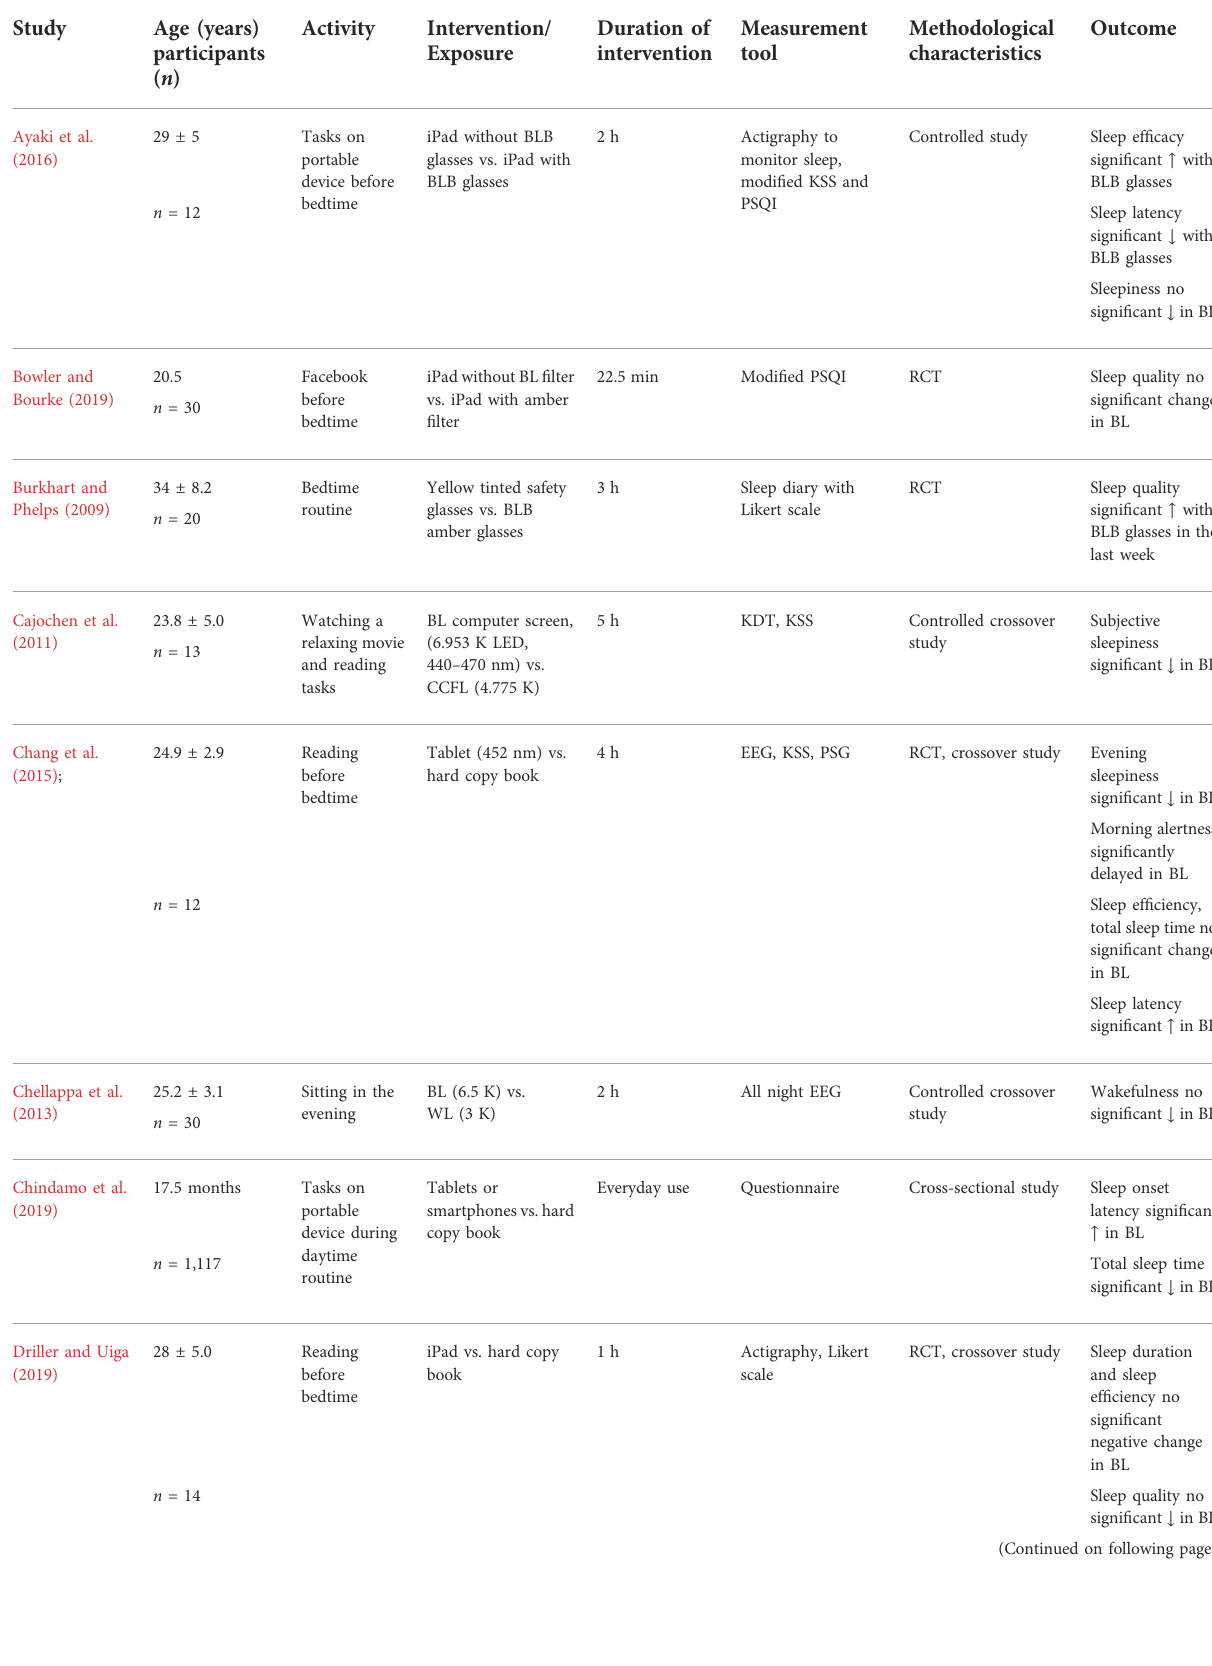
TABLE 3 Effects of blue light on